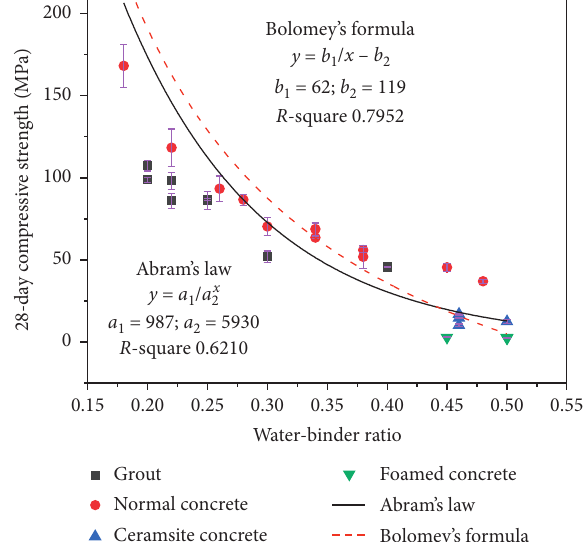
Figure 10: Simulations of Abrams’ law and Bolomey’s formula using water-binder ratio for cement-based